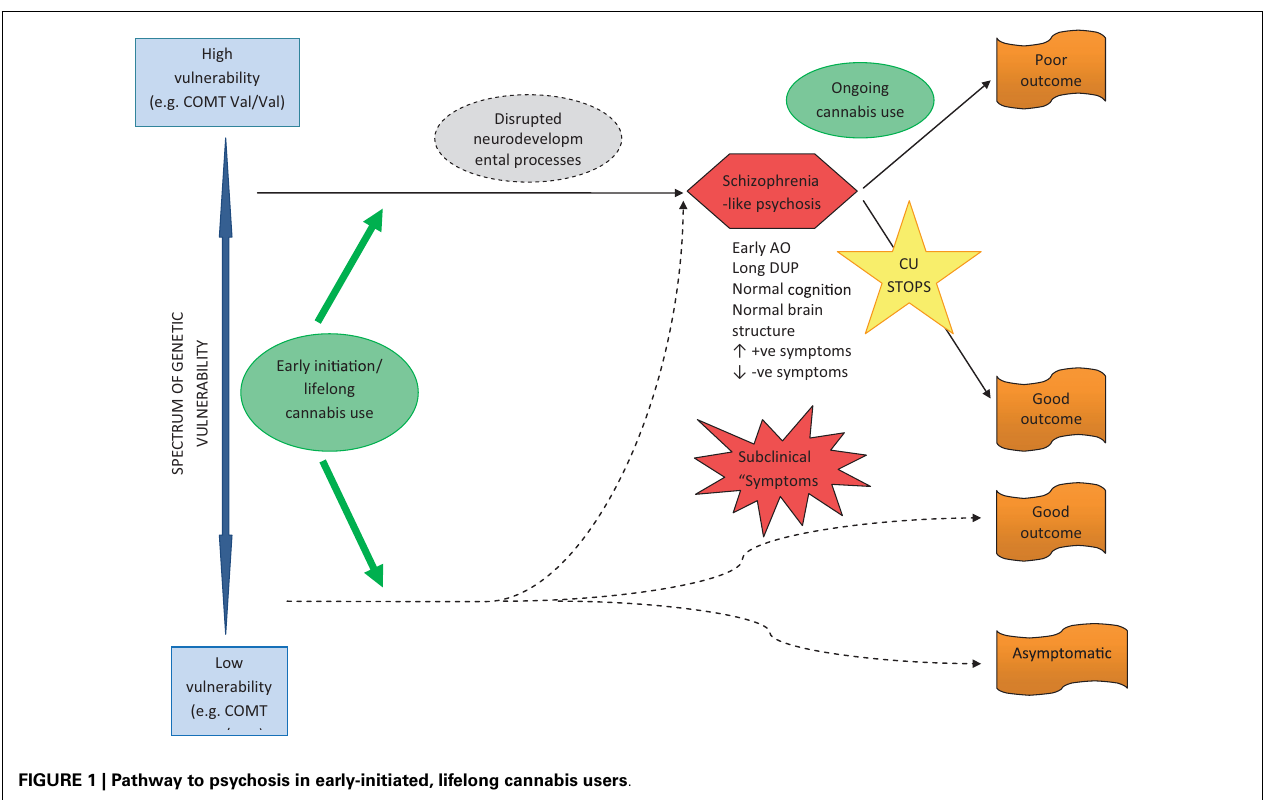
FIGURE 1 | Pathway to psychosis in early-initiated, lifelong cannabis users .